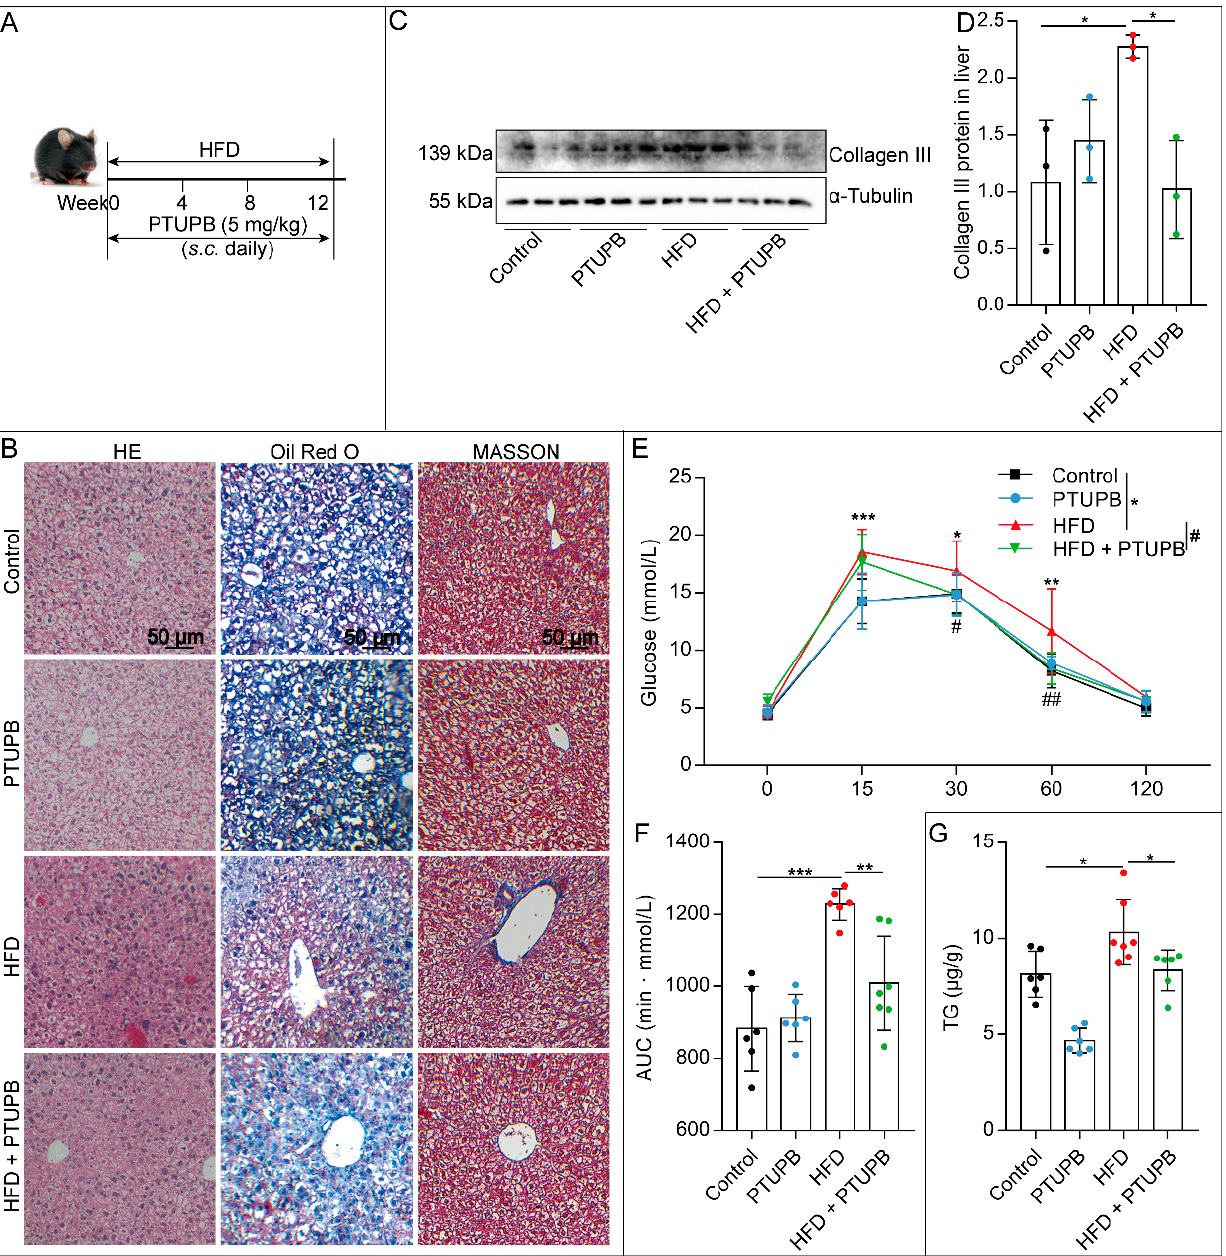
Figure 1. PTUPB reduces HFD-induced NAFLD in mice. PTUPB (5 mg/kg/day, s.c. ) was administered daily ( A ). HE-stained histological images of liver sections from mice ( B ), left column, scale bars = 50 μ m, n = 6. Oil Red O staining of liver sections from mice ( B ), middle column, scale bars = 50 μ m, n = 6. Masson staining of liver sections from mice ( B ), right column, scale bars = 50 μ m, n = 6. Western blot was used to detect collagen III protein expressions and quantitative analysis (( C , D ), n = 6–7). Measurement of blood glucose and AUC during IGTT of mice fed with HFD or normal chow diet for 12 weeks (( E , F ), n = 6–7). Content of TG in liver tissue of mice (( G ), n = 6–7). Data are expressed as the mean ± SD. Differences among multiple groups were performed using ANOVA. Tukey’s test was used as a post hoc test for pairwise comparisons. # or * p < 0.05, ** p < 0.01, and *** p <